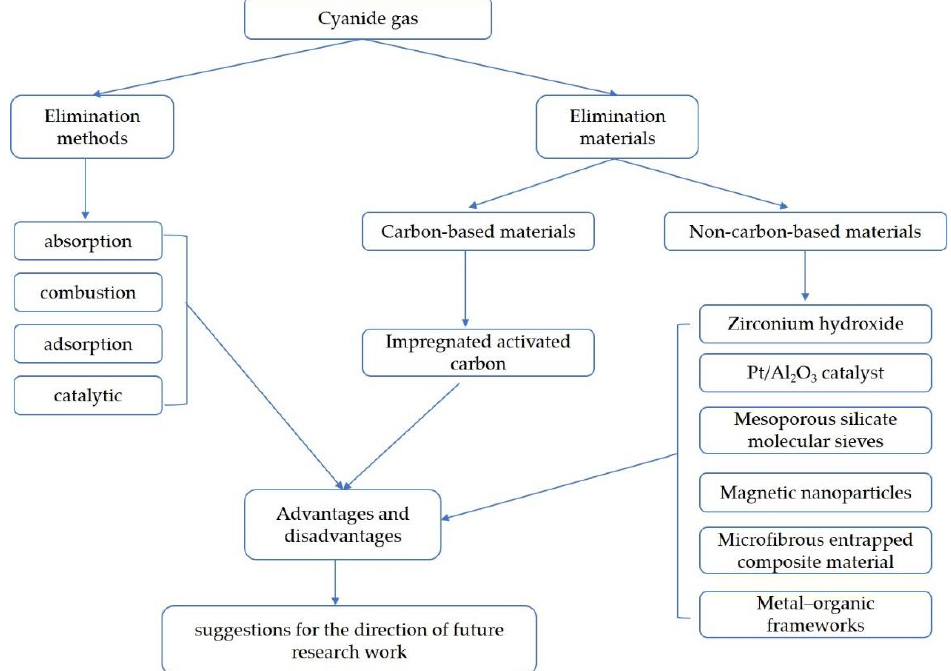
Figure 1. The scope of this